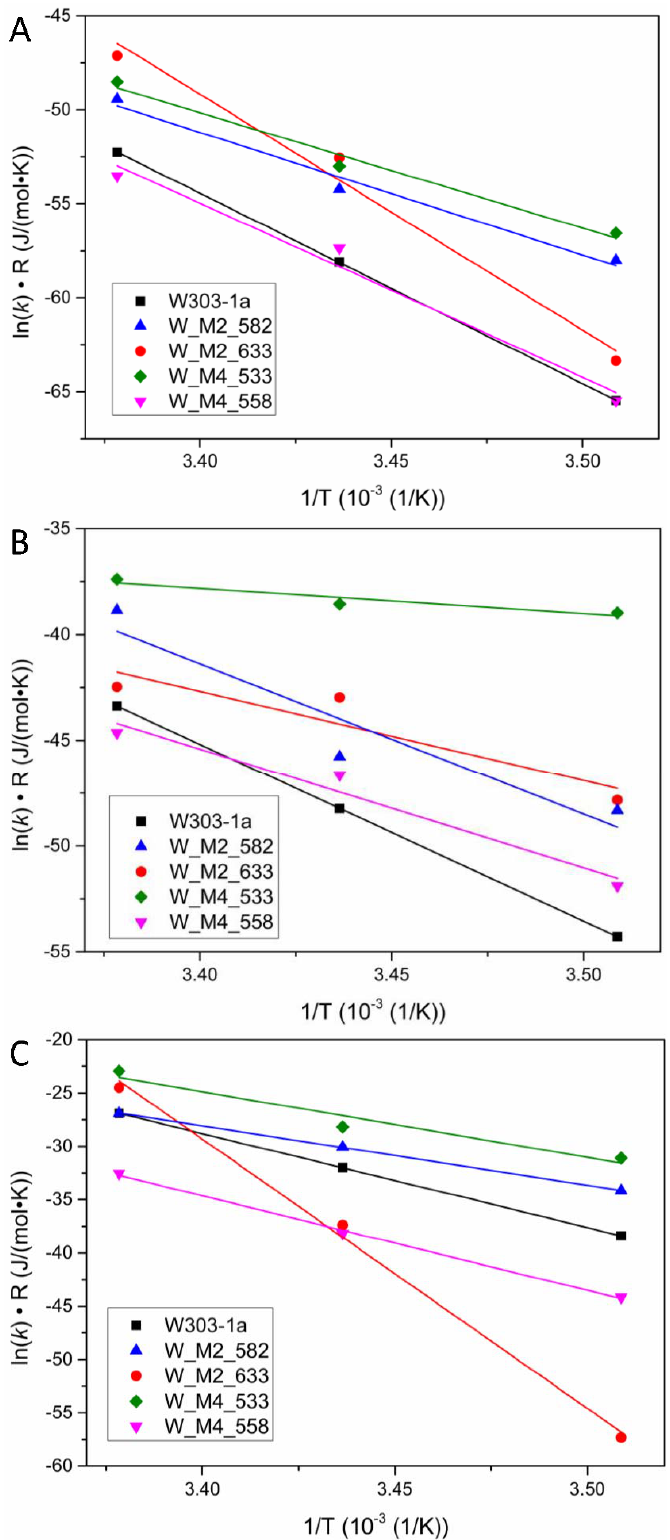
Figure 5. Plots of the ln( k ) · R product against 1/ T , where T is the temperature in Kelvin. The slopes of the resulted lines correspond to the activation energy of the reaction during each phase of alcoholic fermentation according to Arrhenius model for each studied strain. ( A ) Lag phase, ( B ) Log phase, ( C ) Stationary/Death phase.